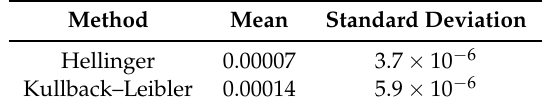
Table 1. Result of distance calculation between synthetic data and reconstruction.